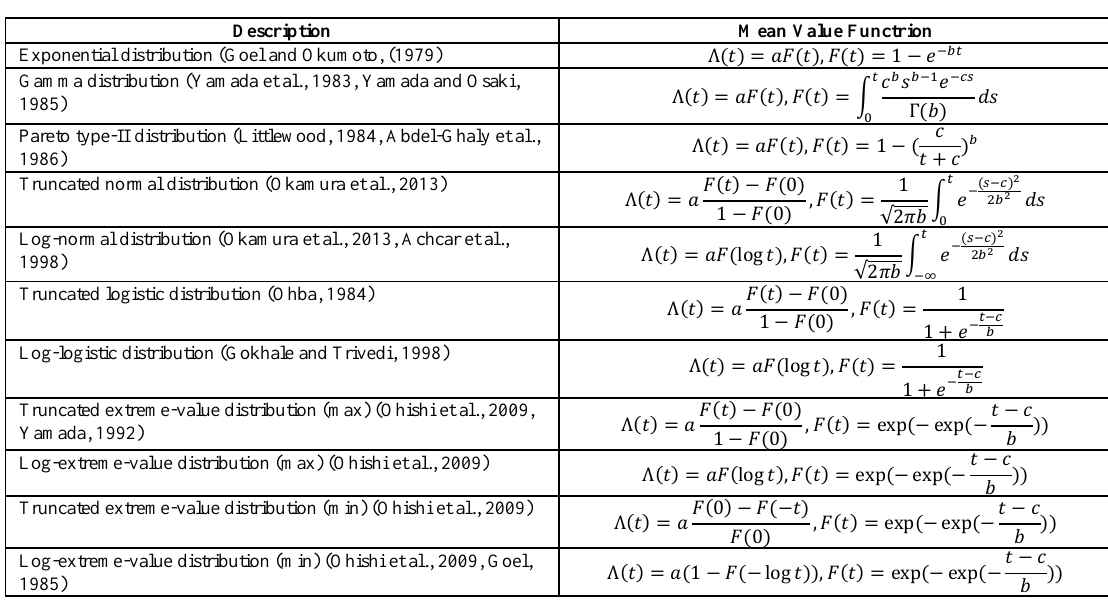
Table 1. The commonly used NHPP-based